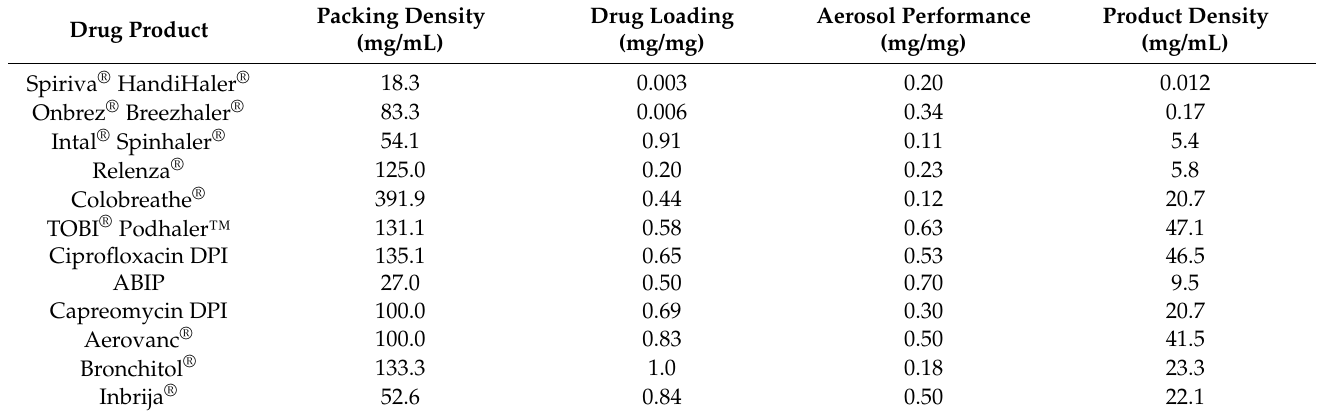
Table 1. Product density metrics for various late-stage and marketed